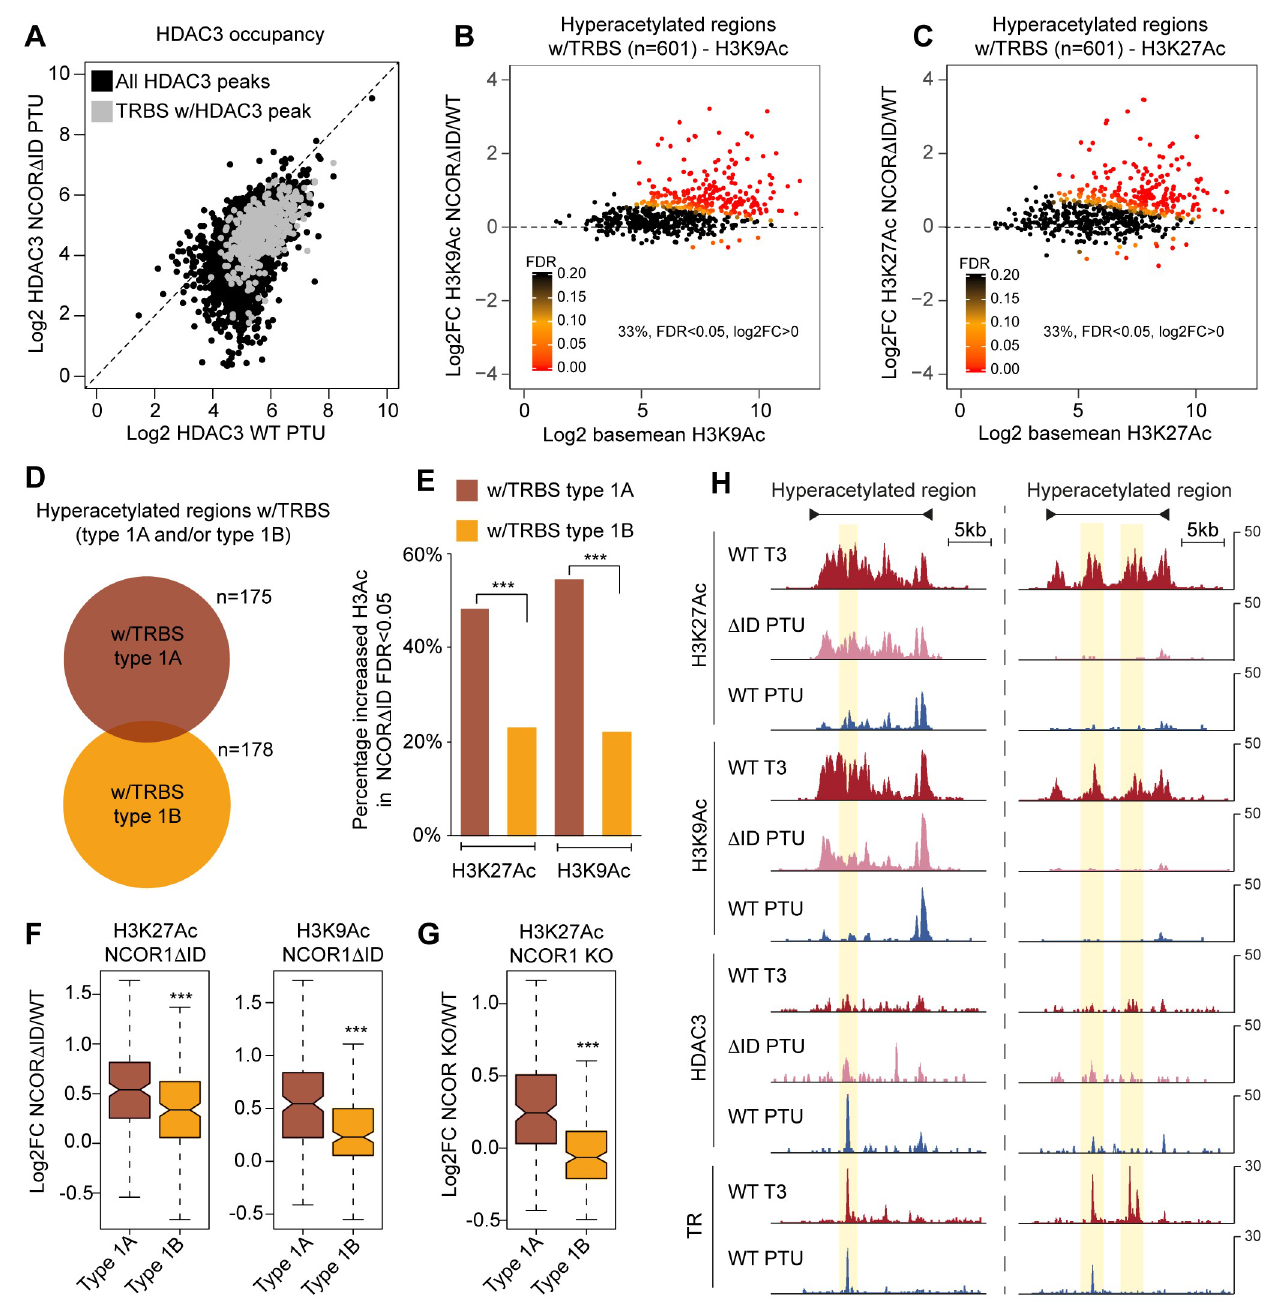
Fig 4. Histone acetylation of TR occupied regions due to disrupted interaction between TR and NCoR. (A) HDAC3 occupancy of chromatin in WT mice and mice expressing a mutated NCOR1 (NCOR1 Δ ID) unable to interact with TR. TRBSs occupied by HDAC3 are marked with grey. (B) Differential H3K9Ac of hyperacetylated regions in WT hypothyroid mice compared to hypothyroid NCOR1 Δ ID mice. (C) Differential H3K27Ac of hyperacetylated regions in WT hypothyroid mice compared to hypothyroid NCOR1 Δ ID mice. (D) Genomic overlap of hyperacetylated regions occupied by TR (w/TRBS) and low or high occupancy of NCOR1-HDAC3. (E) Fraction of hyperacetylated regions with increased H3K9Ac and H3K27Ac in livers from hypothyroid L-NCOR1 Δ ID mice compared to hypothyroid WT mice. ��� Fisher’s exact test p < 0.001. (F) Fold change of H3K9/27Ac at hyperacetylated regions occupied by TR and associated with high and low occupancy of NCOR1-HDAC3 in livers from hypothyroid L-NCOR1 Δ ID mice compared to hypothyroid WT mice. Statistical difference was determined by a Wilcoxon Signed Rank Test, ��� p < 0.001. (G) Fold change of H3K27Ac at hyperacetylated regions occupied by TR and associated with high and low occupancy of NCOR1-HDAC3 in livers from hypothyroid NCOR1 KO mice compared to hypothyroid WT mice. Statistical difference was determined by a Wilcoxon Signed Rank Test, ��� p < 0.001. (H) Examples of hyperacetylated regions occupied by type 1A TRBS (left, chr16:21,817,000–21,842,000) and type 1B TRBS (right, chr2:167,527,000–167,558,000).